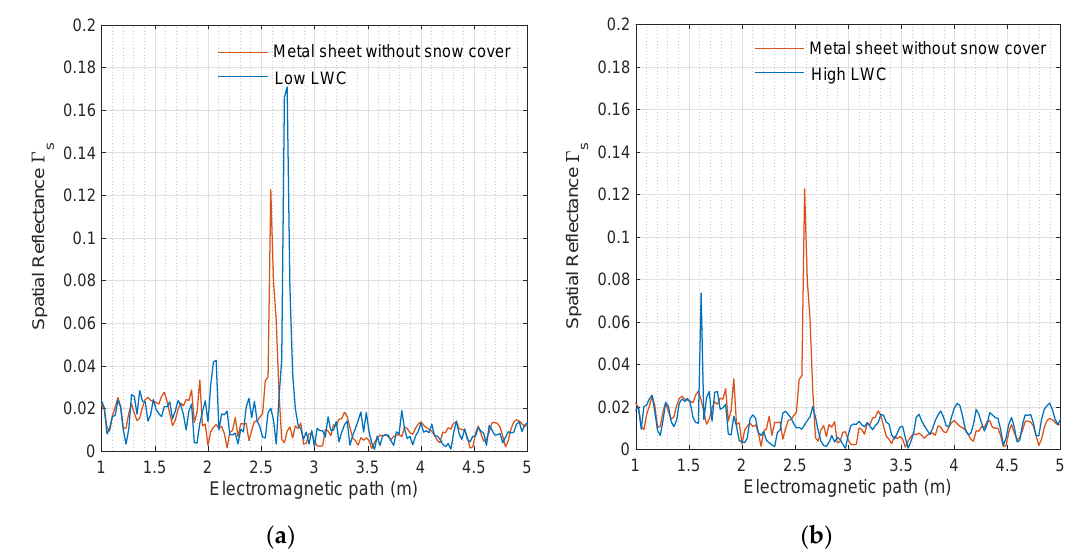
Figure 17. Spatial reflectance of two measurements compared with the metal sheet without snow cover case (orange): ( a )